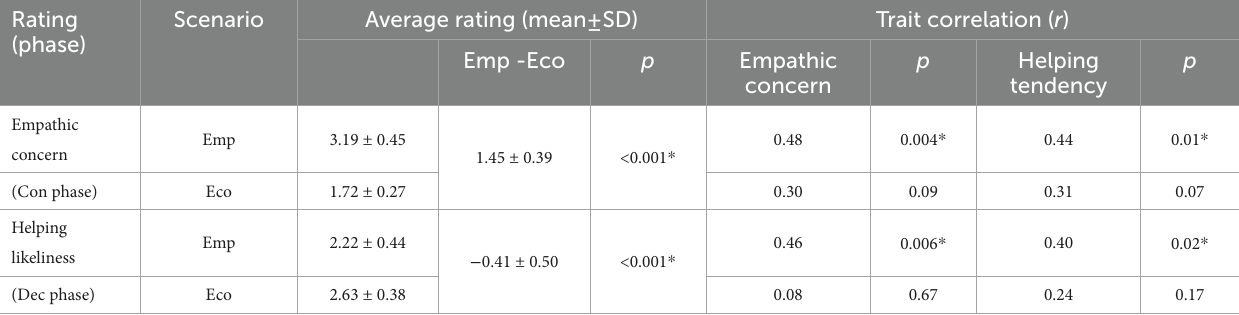
TABLE 1 Behavioral data.